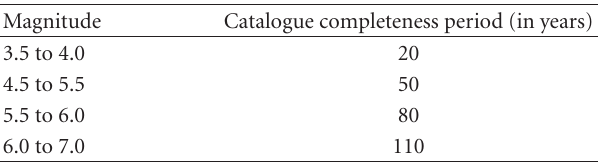
Table 1: Catalogue completeness with respect to time and magni- tude